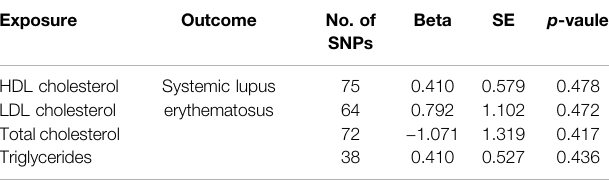
TABLE 3 | Multivariable MR analysis between SLE and blood lipids. Exposure